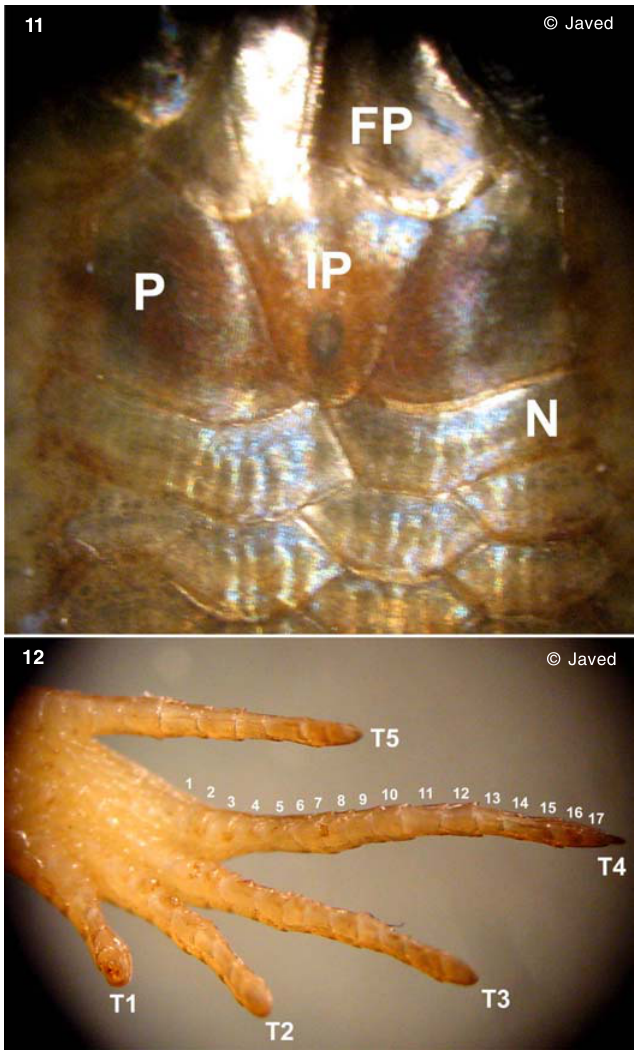
Images 11-12. Eutropis innotata. 11 - Dorsal aspect of nape showing fronto-parietals (FP), interparietal (IP), parietals (P) and nuchals (N); 12 - Ventral aspect of hind-limb showing 5 toes with feebly keeled lamellae